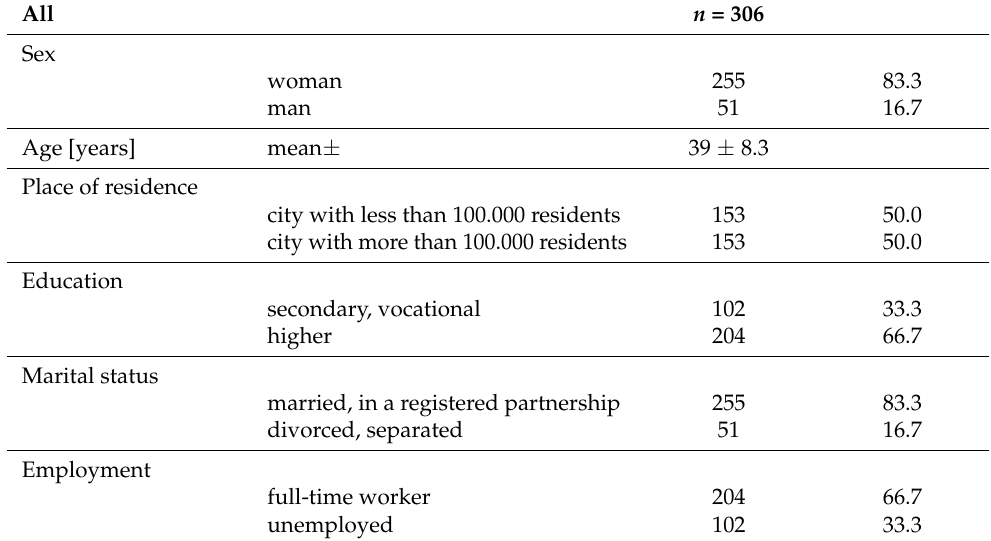
Table 1. Target group